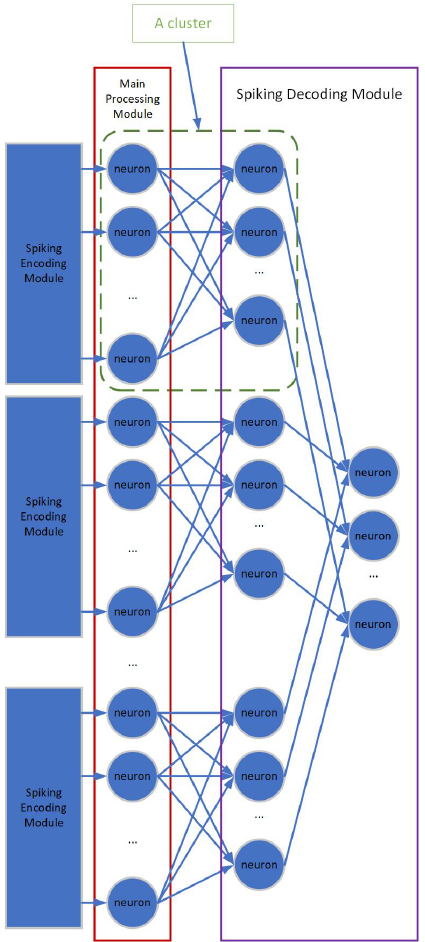
Figure 2. Illustration of the cluster-grouped structure mode of our